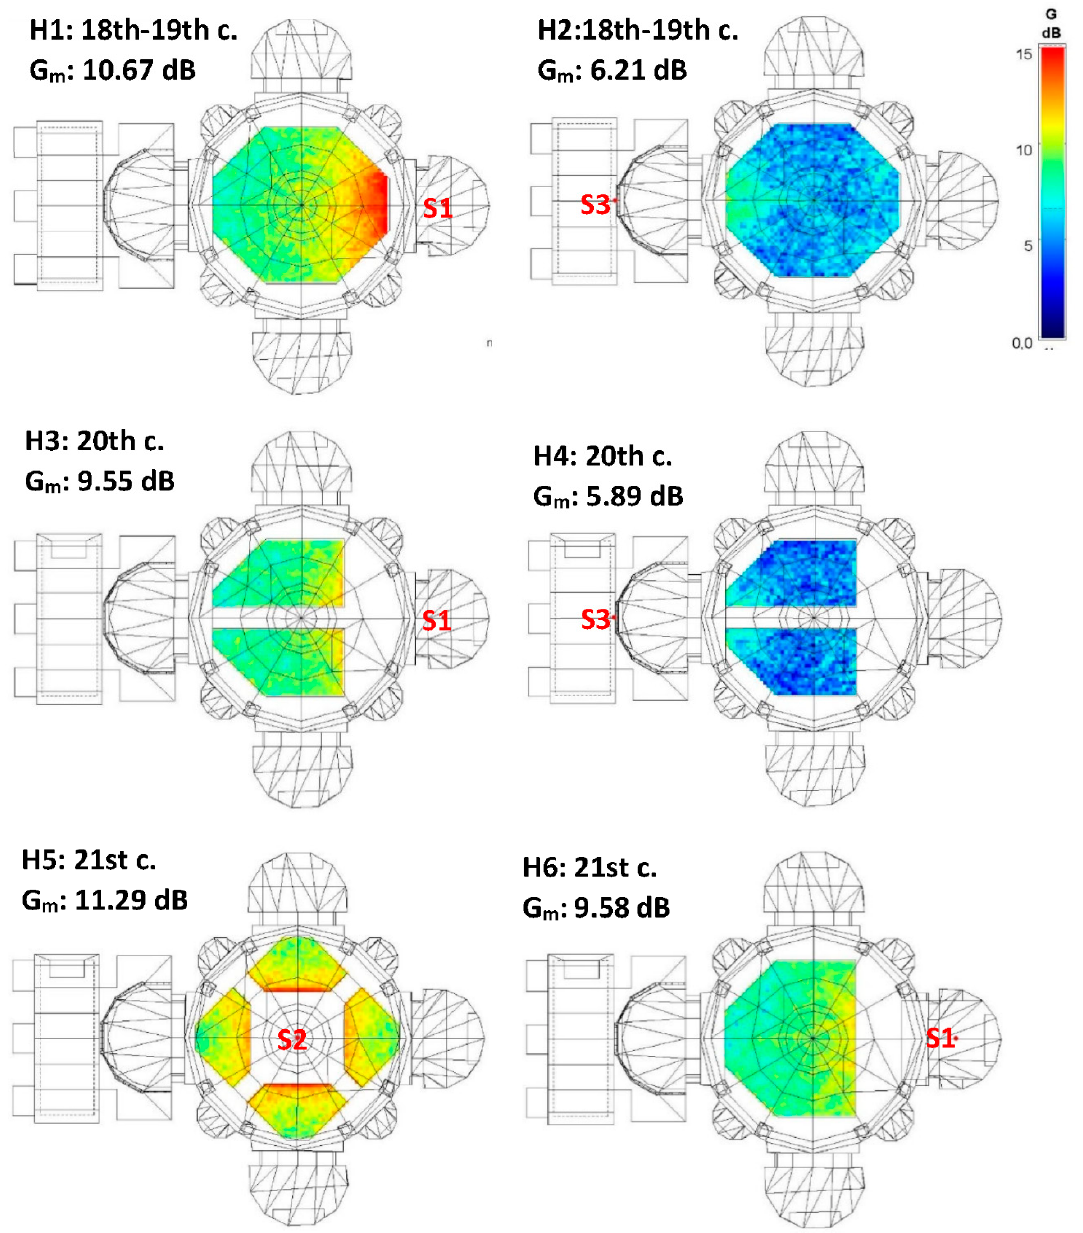
Figure 11. Sound force mapping 1 kHz octave band and for the different hypotheses. S1 (main altar), S2 (dome) and, S3 (choir).